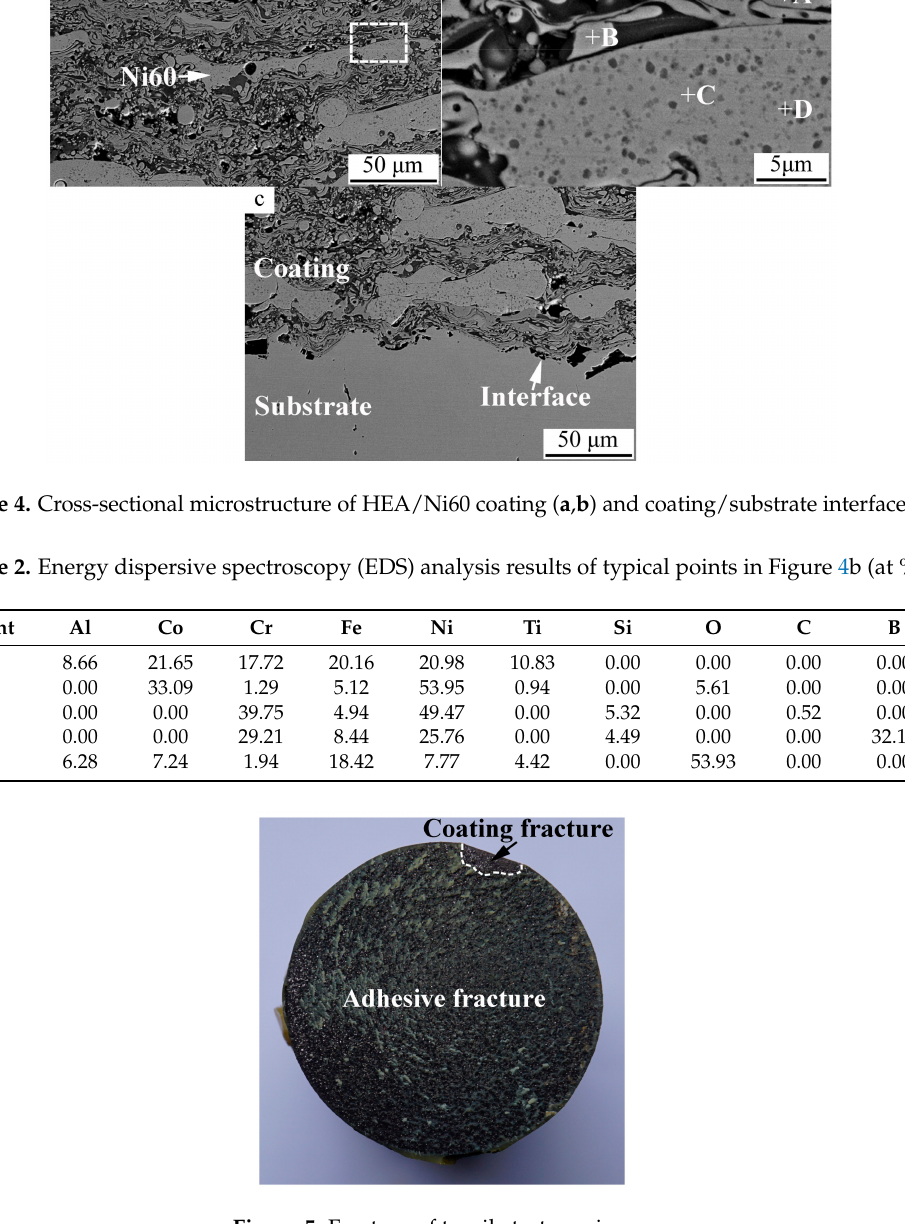
Figure 5. Fracture of tensile test